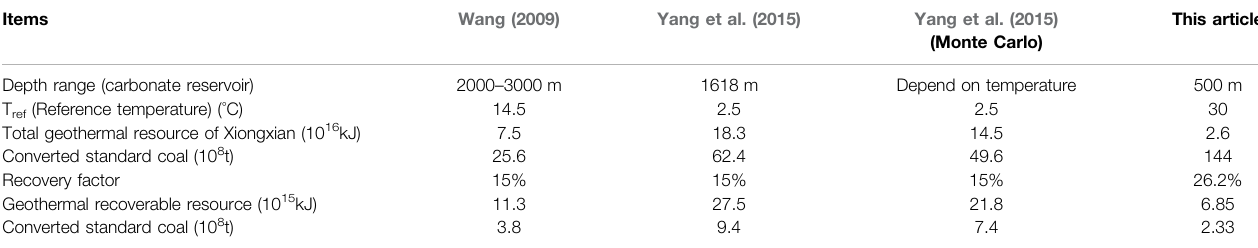
TABLE 2 | Assessment of the recoverable geothermal resources in the Xiongxian geothermal fi eld.